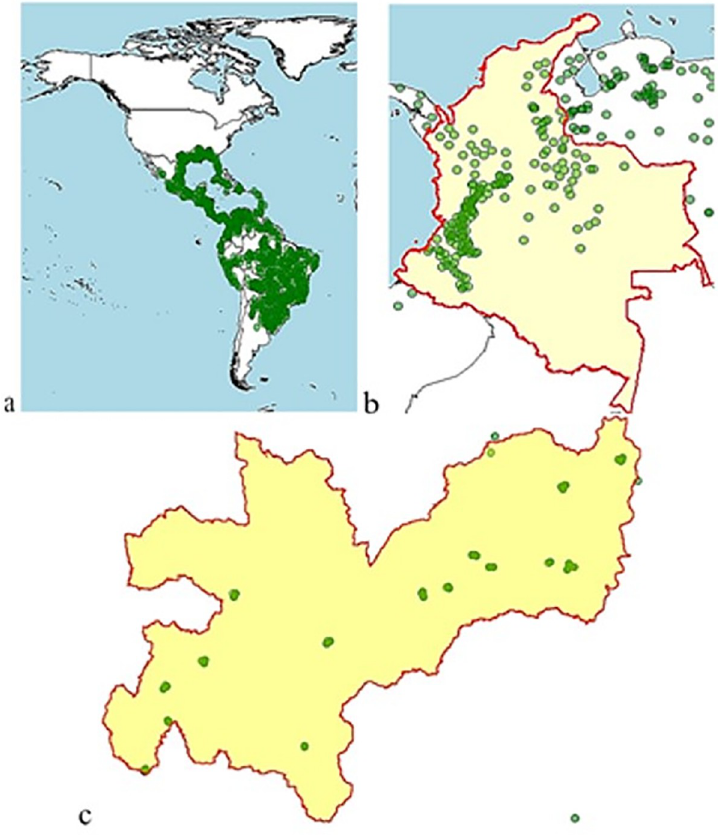
Fig 4. Presence points of Diatraea spp. at different scales. a) Western Hemisphere, b) Colombia and c) Department of Caldas. Dots indicate records of presence.